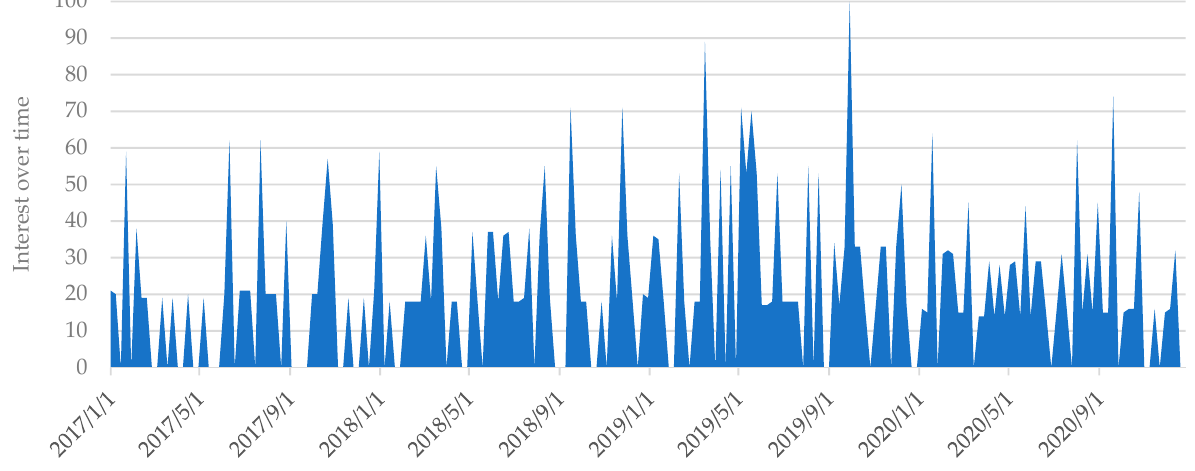
Figure 4. Interest over the last four years in DIH, generated via Google Trends.